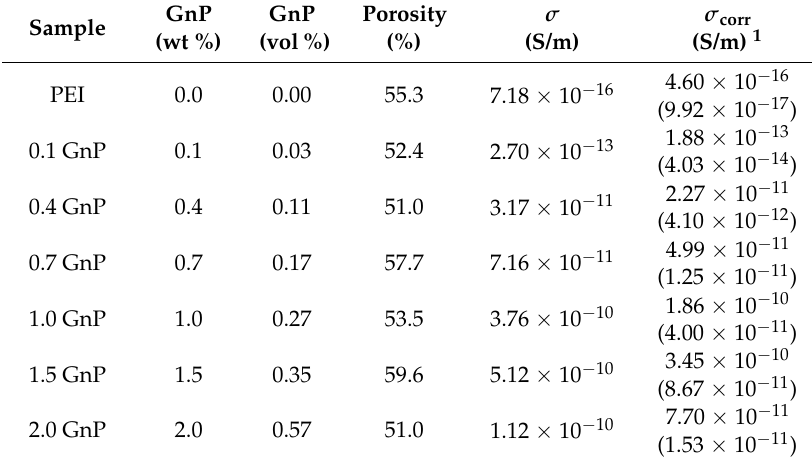
Table 5. Electrical conductivity and corrected electrical conductivity values of pure PEI and PEI-GnP nanocomposite foams.